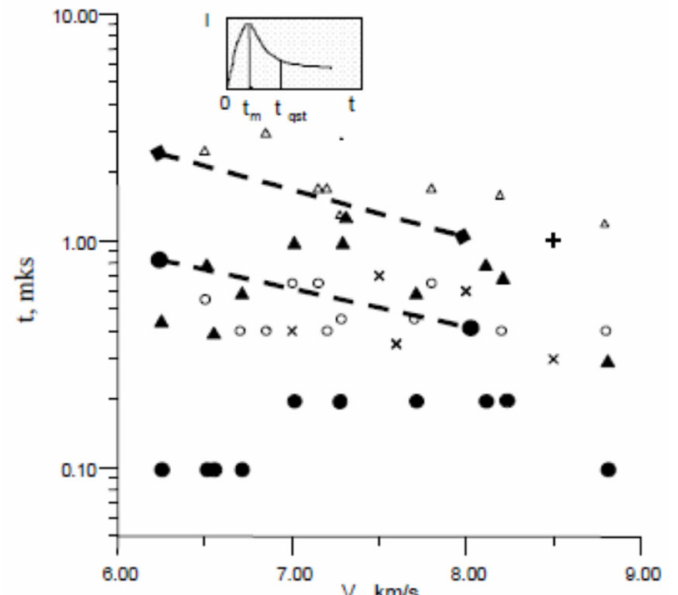
Figure 41. Measured and calculated time-response characteristics of the non-equilibrium radiation peak CO(4+) and CN(violet) behind shock wave versus velocity. (1) measurements • –t m (time to reach radiation maximum during a shot) for CO(4+); (cid:78) –t qst () for CO(4+); ∆ –t qst (characteristic time for non-equilibrium radiation peak duration) for CN(violet); –t m for CN(violet); X from [39]. (2) (cid:35) calculations: curves–t m for CN(violet), –t qst for CN(violet) (from [38]).